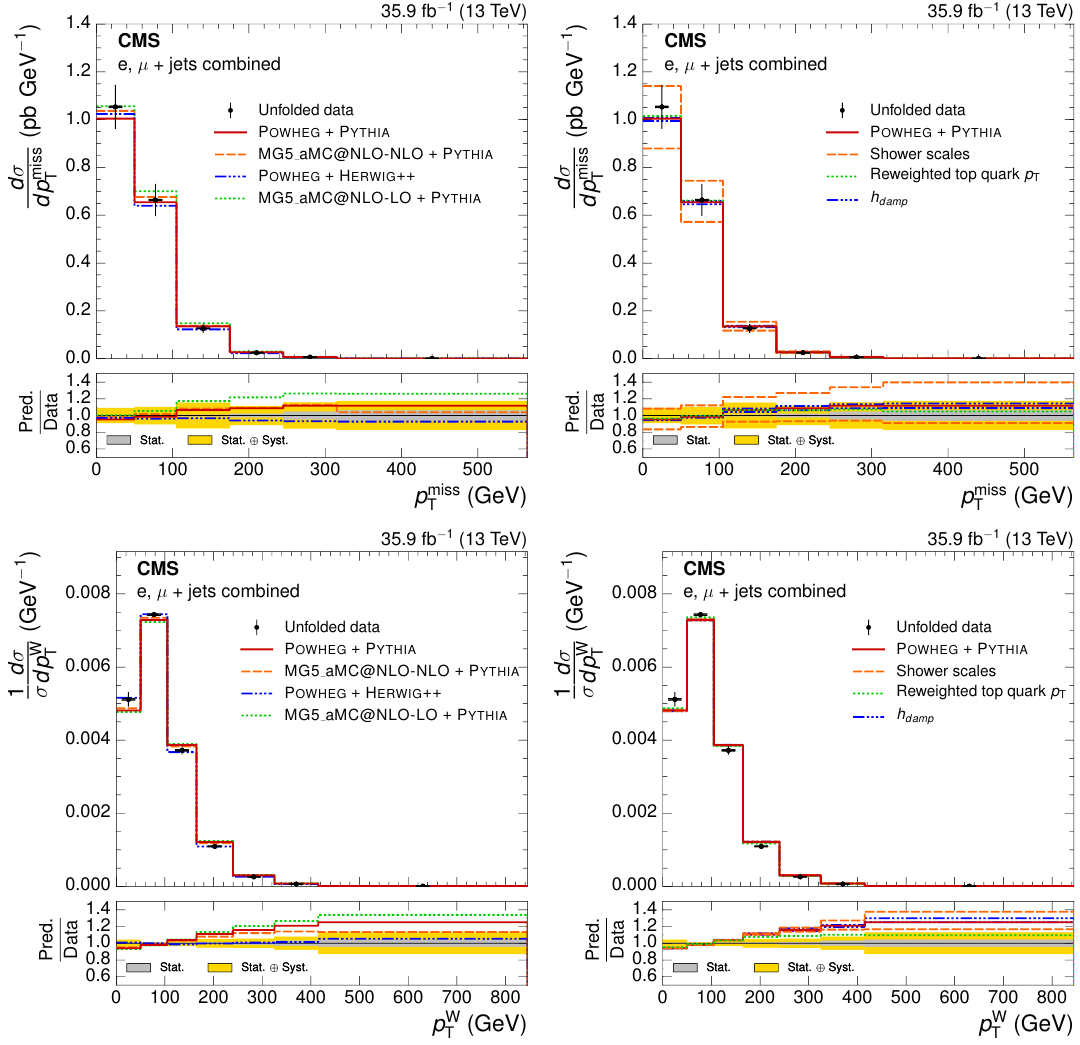
Figure 5 . Normalized p miss (upper) and p W (lower) di(cid:11)erential tt cross sections, compared to T T di(cid:11)erent tt simulations in the left plots, and compared to the powheg + pythia simulation after varying the shower scales, and h damp parameter, within their uncertainties, in the right plots. The vertical bars on the data represent the statistical and systematic uncertainties added in quadrature. The bottom panels show the ratio of the predictions to the